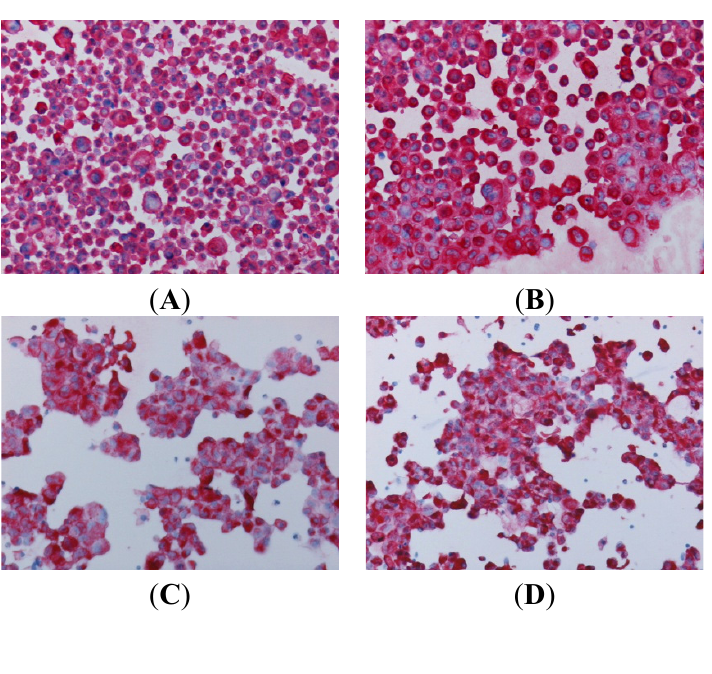
Figure 2. Phenotypical analysis of two primary tumor cultures. Cytokeratin immunofluorescence analyses of primary cultures derived from ovarian tumor at 4th ( A ) and 40th ( B ) passage, and from a clear renal cell carcinoma at 4th ( C ) and 20th ( D ) passage (Magnification